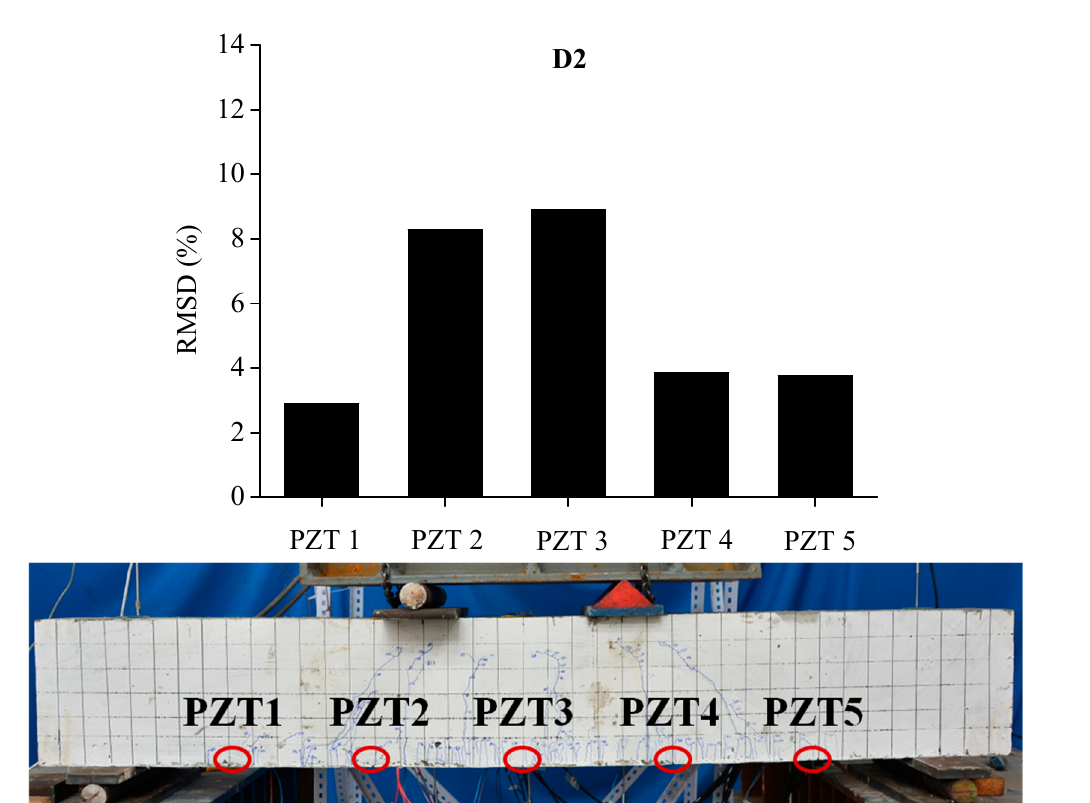
Figure 14. RMSD of each PZT sensor at D2 and the related cracking pattern of BE1.